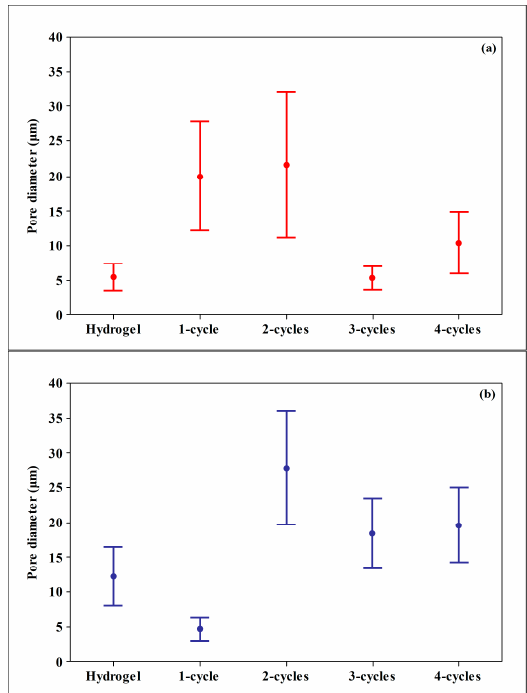
Figure 3 Figure 3. Confidence intervals at 95% of the polymer pore diameter: ( a ) xanthan; ( b ) karaya.